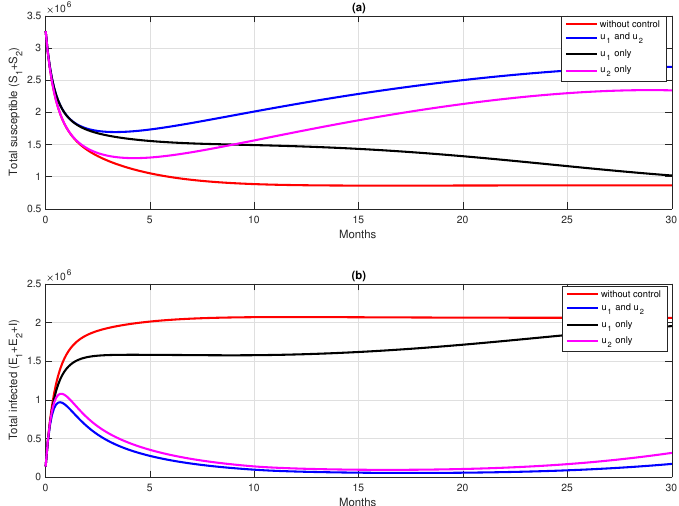
Figure 11. Dynamics of total susceptible human ( a ) total of infected human ( b ) for four different strategies (no intervention (red), u 1 and u 2 (blue), u 1 only (black), and u 2 only